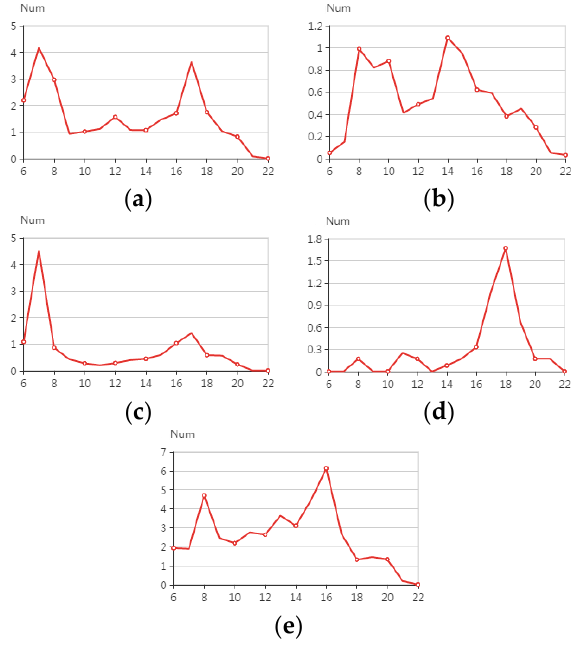
Figure 4. User cluster results. ( a ) cluster 1; ( b ) cluster 2; ( c ) cluster 3; ( d ) cluster 4; ( e ) cluster 5.